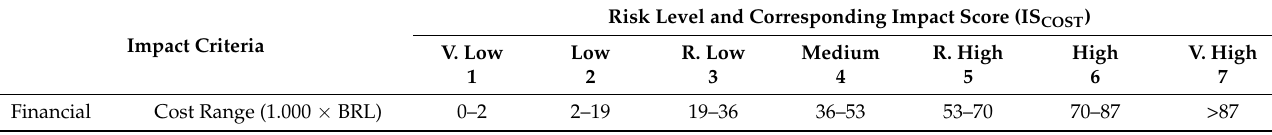
Table 5. Scoring criteria for pipe repair (IS COST